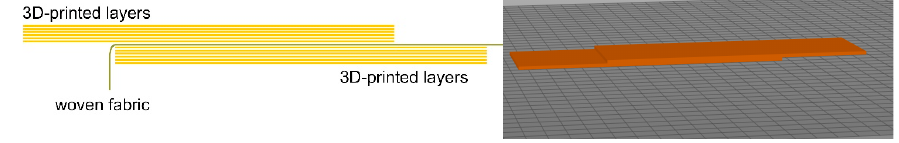
Figure 1. 3D sample model for breaking force test.